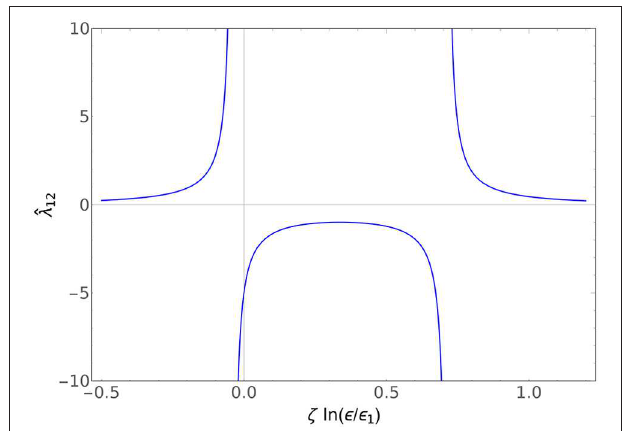
y 2 y 3 ζ 2 , y 1 1, and = = = = +